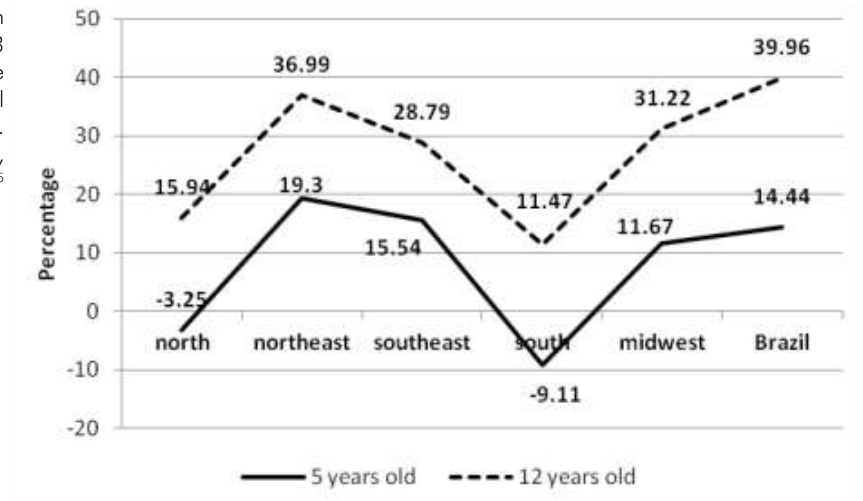
Figure 1: Difference between epidemiological data from 2003 and 2010, in the percentage of caries-free individual at the ages of 5 and 12 years. Source: Brasil 2009, Brasil 2011 24,25